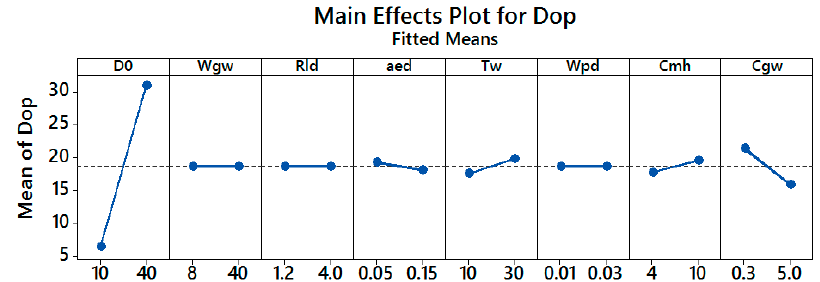
Figure 4. Main effects plot for optimum replaced grinding wheel diameter.